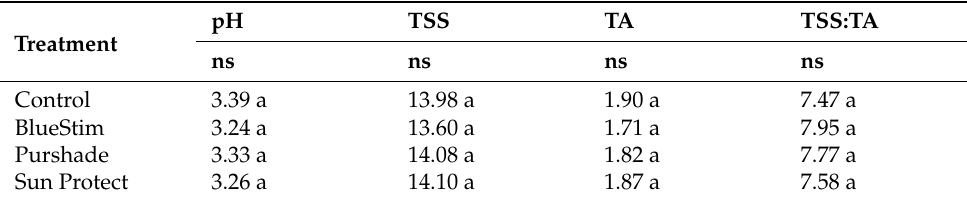
Table 4. Alleviating products’ effect on kiwifruit juice pH, total soluble solids (TSS) ( ◦ Brix), titratable acidity (TA) (g citric acid 100 g − 1 fresh weight), and the ratio of total soluble solids: titratable acidity (TSS:TA) after storage at 0.5 ◦ C for 107